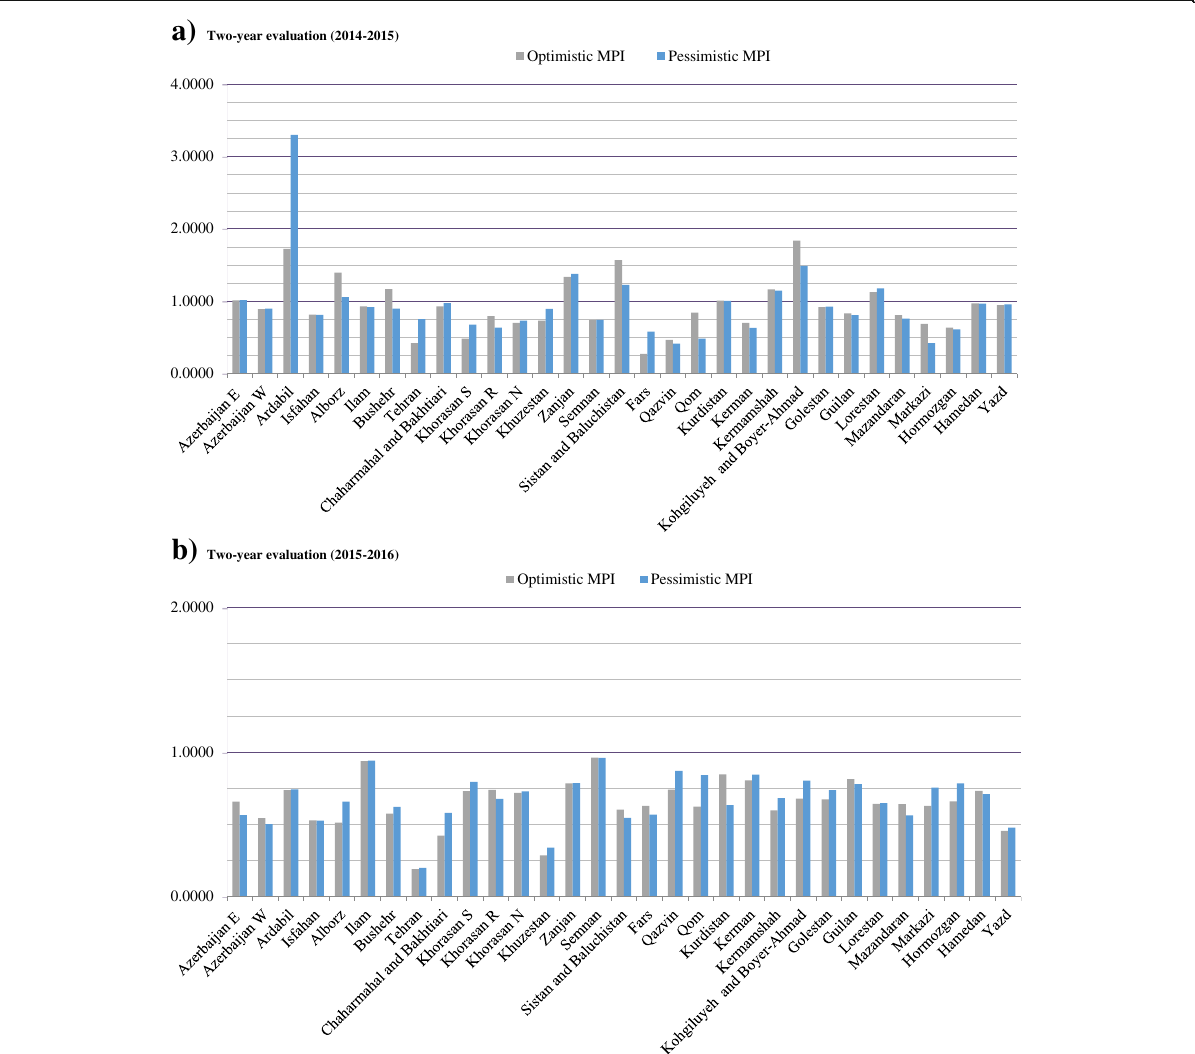
Fig. 5 Comparison of Malmquist productivity index values from the two points of view, (a) optimistic MPI and (b) pessimistic